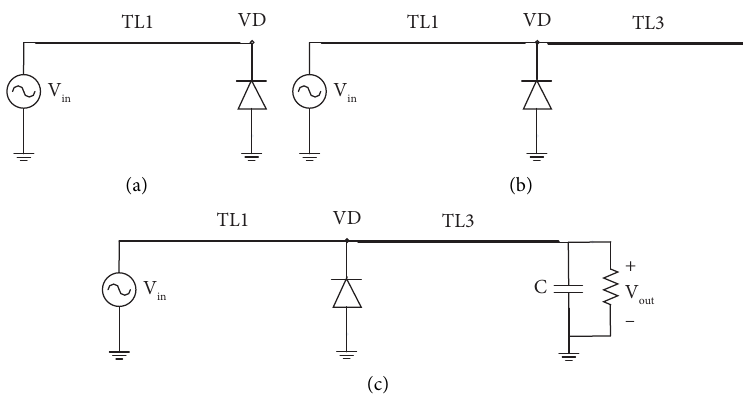
Figure 13: Decomposition circuit with SBD in shunt: (a) microstrip line and SBD in shunt, (b) adding microstrip line on the basis of (a), and (c) rectifying circuit with SBD in